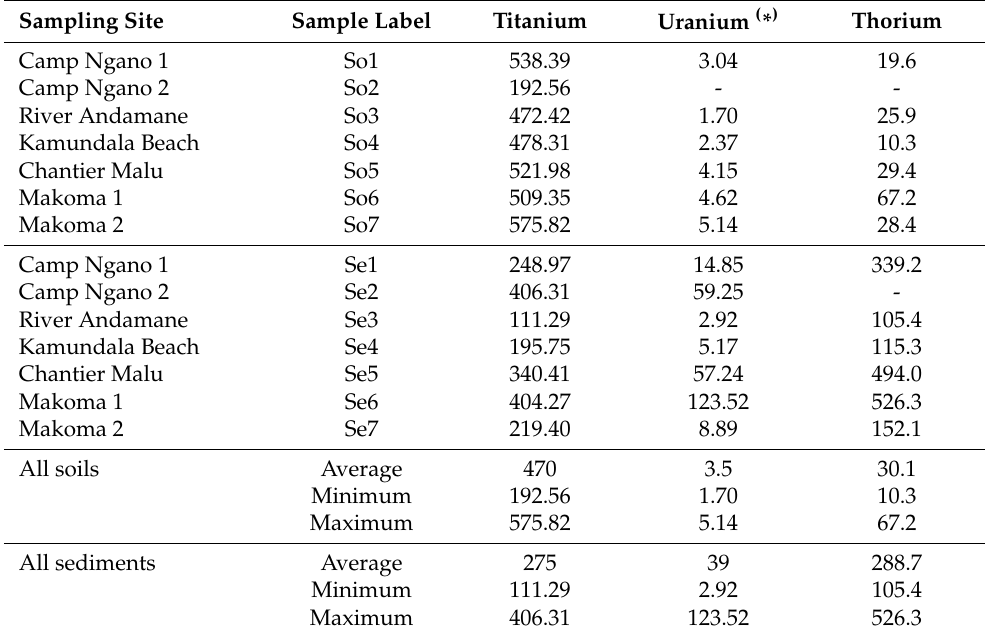
Table 5. Ti, U, and Th mass concentrations (mg kg − 1 dry weight) in soil and sediment samples. Ti and Th mass concentrations were determined by ICP-MS, and U mass concentration was calculated using gamma spectrometry